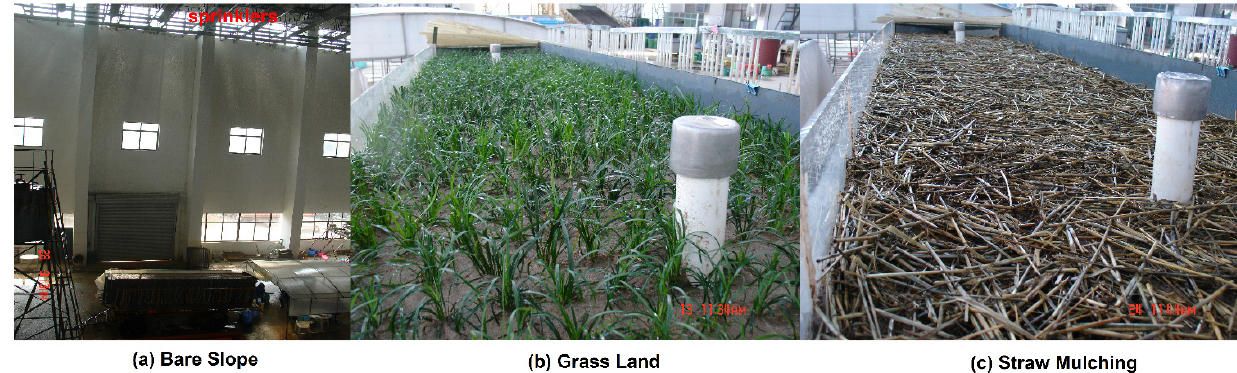
Figure 2. Pictures of different soil and water conservation measures: ( a ) Bare Slope; ( b ) Grass Land; ( c ) Straw